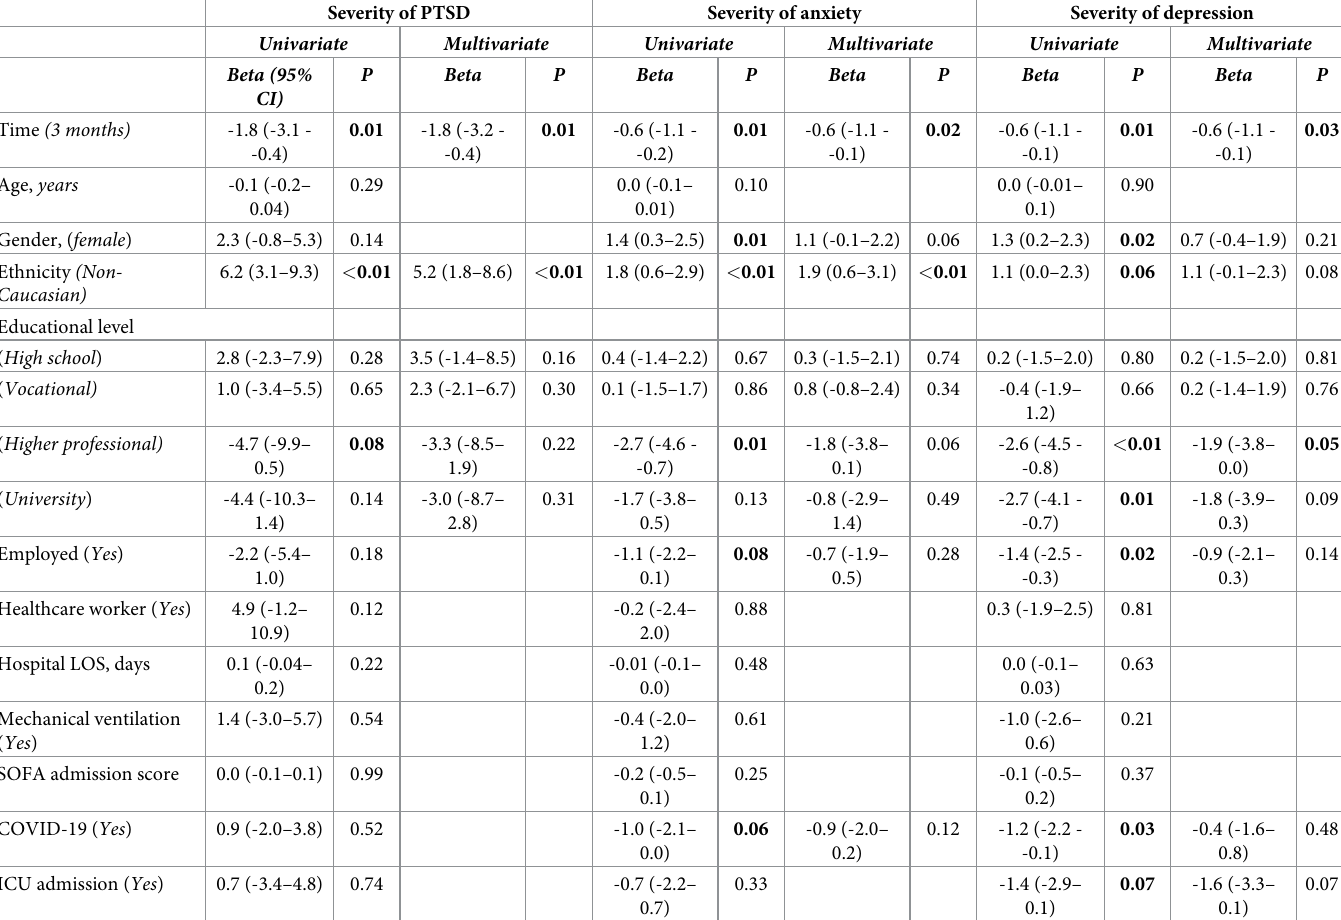
Table 4. Predictors for the severity of PTSD, anxiety, and